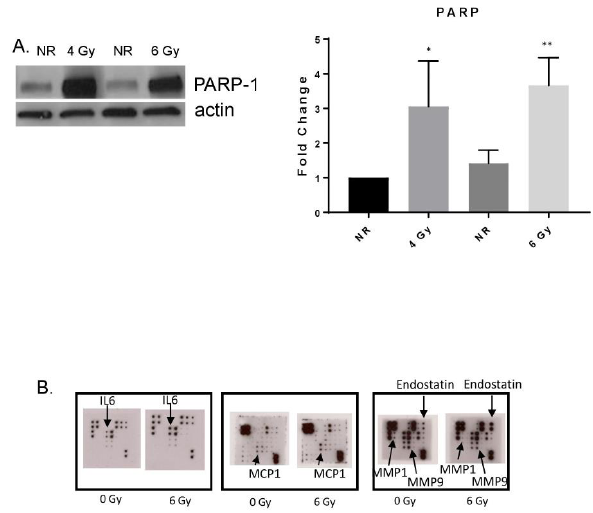
Figure 2. MF radiation increased protein expression in BMEC . ( A ) Increased PARP-1 expression was detected 4 h postradiation (6 Gy). Densitometry was performed on three independent experiments, normalized to actin. * p = 0.0326; ** p = 0.0086. Significance was determined compared to NR conditions. Error bars represent standard deviation. ( B ) Secreted proteins were analyzed from cell culture supernatant 24 h post-radiation (6 Gy) using antibody